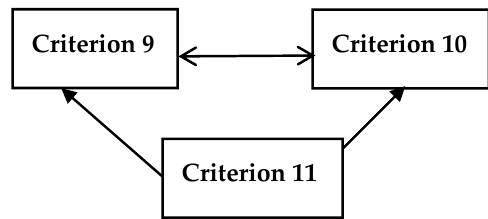
Figure 6. Impact-relation map for the criteria of catastrophic health spending.